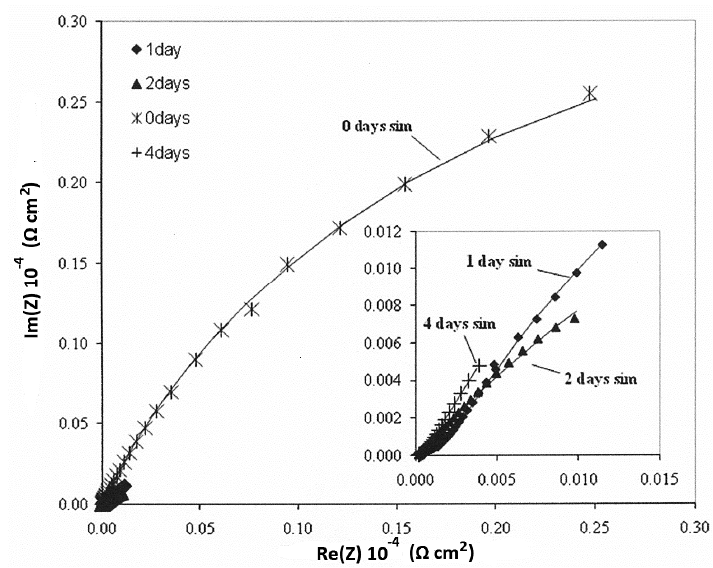
Figure 12. Nyquist plots of impedance spectra, R e (Z), real part of impedance, and I m (Z), imaginary part of impedance, for epoxy coated specimens after 0, 1, 2, or 4 days of exposure in a corrosive environment of 3.5 wt % NaCl solution.